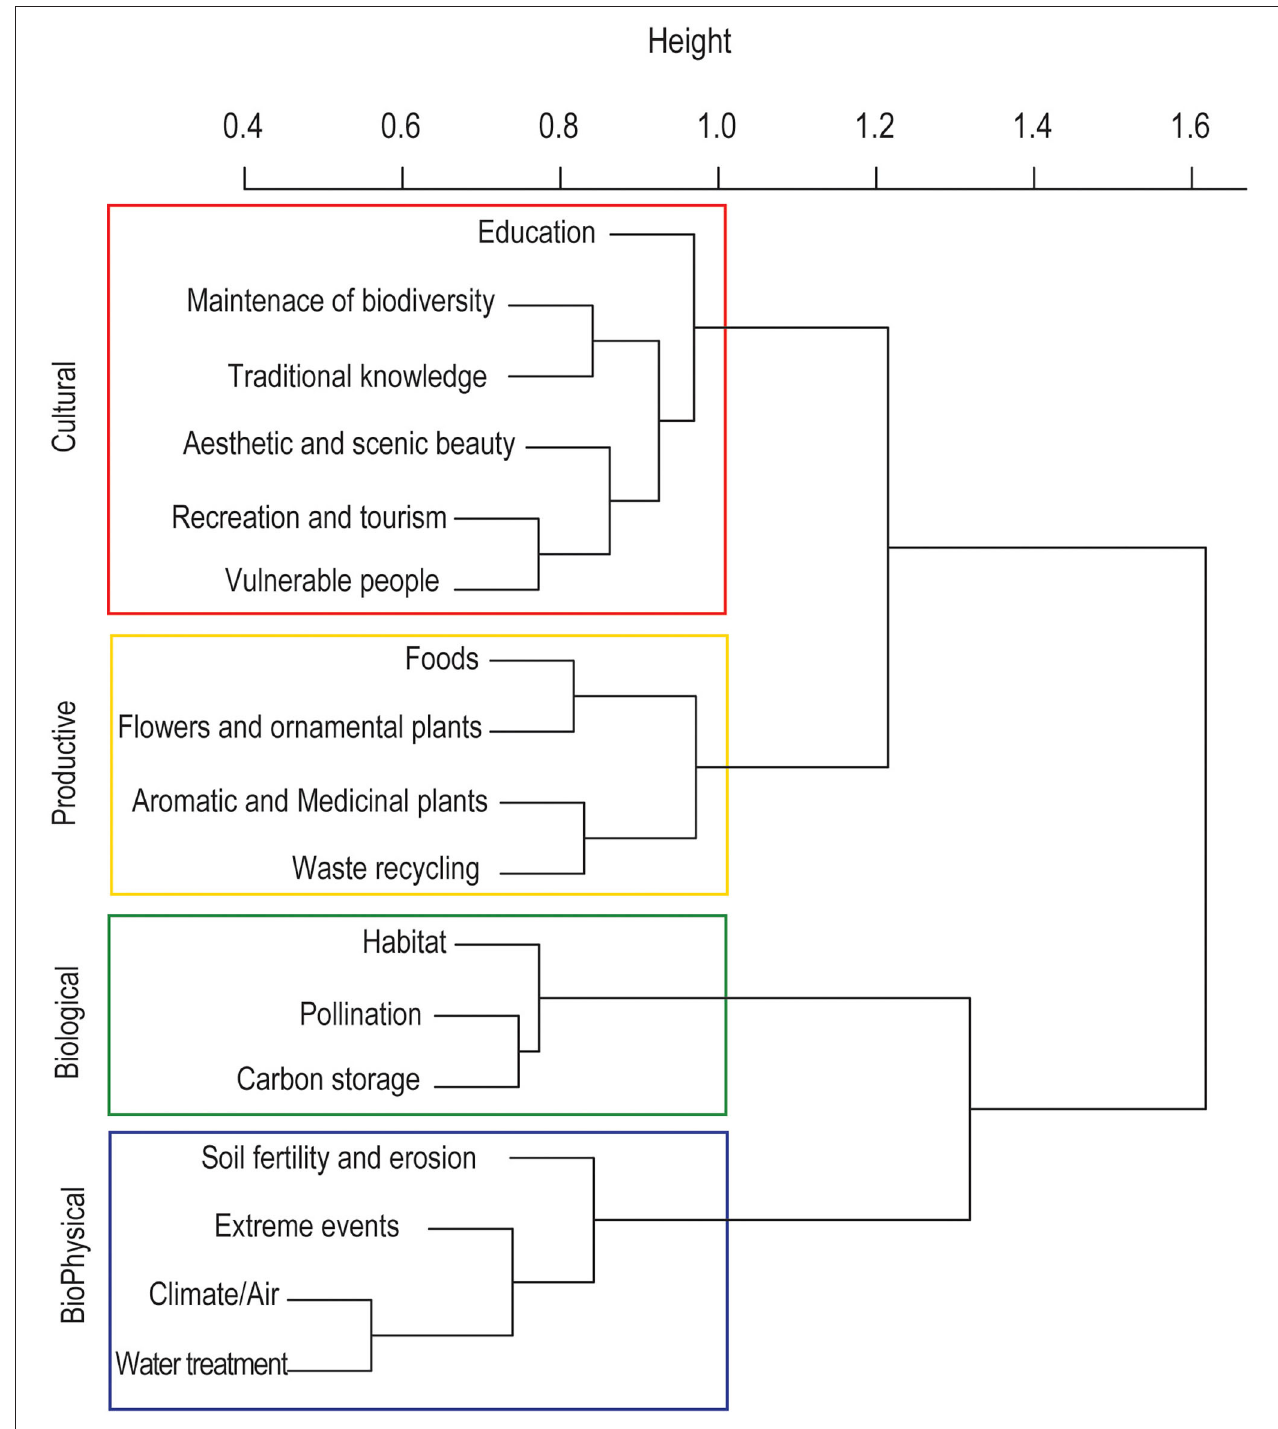
FIGURE 1 | Ecosystem service bundles of UA in LA through a cluster analysis.